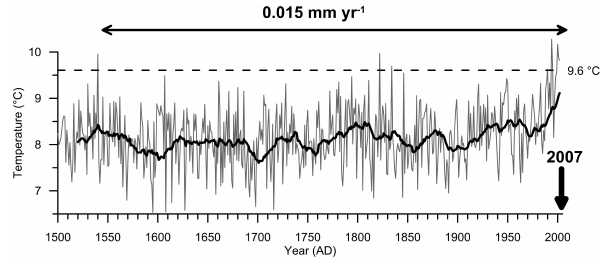
Figure 6. Surface temperature reconstruction (47–48 ◦ N; 6.5– 7.5 ◦ E; Luterbacher et al., 2004). The grey graph shows the annual temperatures, a 20 yr running average is plotted in black. The cur- rent cave temperature is shown as a dashed line. The black horizon- tal arrow denotes the estimated temporal coverage of the studied 6mm long section of stalagmite M2 assuming an average growth rate of 0.015mm per year. The vertical black arrow denotes the age of the top (date of sampling) of stalagmite M2.